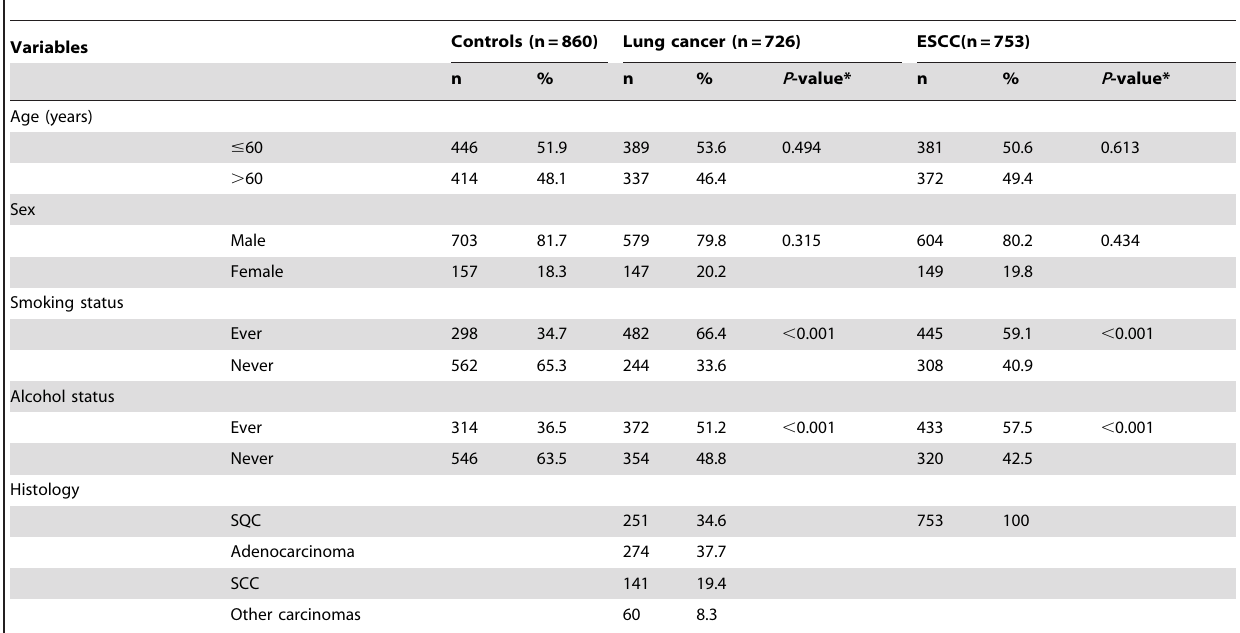
Table 1. Characteristics of lung cancer and esophageal squamous cell carcinoma (ESCC) patients and healthy controls.